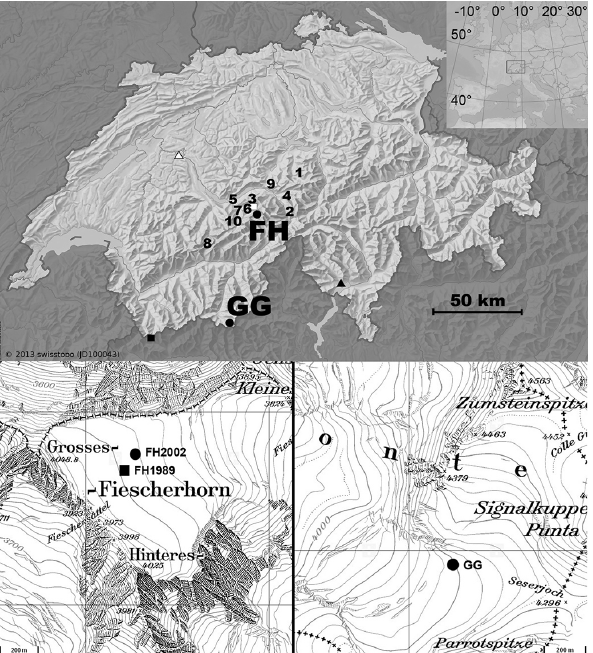
Figure 1. Upper panel: topographic map of Switzerland show- ing the position of the two glaciers (black dots), Fiescherhorn (FH), and Grenzgletscher (GG) (source: Atlas of Switzerland, http: //www.atlasderschweiz.ch/), together with the location of Switzer- land in Europe (insert). The numbers indicate the weather stations near the Fiescherhorn, as listed in Table 2. Engelberg (1), Grimsel Hospiz (2), Grindelwald (3), Guttannen (4), Interlaken (5), Kleine Scheidegg (6), Lauterbrunnen (7), Leukerbad (8), Meiringen (9), Mürren (10). Squares indicate the location of the Jungfraujoch (white) and Grand Saint Bernard (black) weather stations and the triangle the position of the low-altitude stations Bern (white) and Locarno (black). Lower panels: topographic map of the ice core drilling sites (source: Swisstopo, http://map.geo.admin.ch/). The left panel shows the location of the FH1989 and FH2002, the right panel shows the position of the Grenzgletscher drilling site (GG).